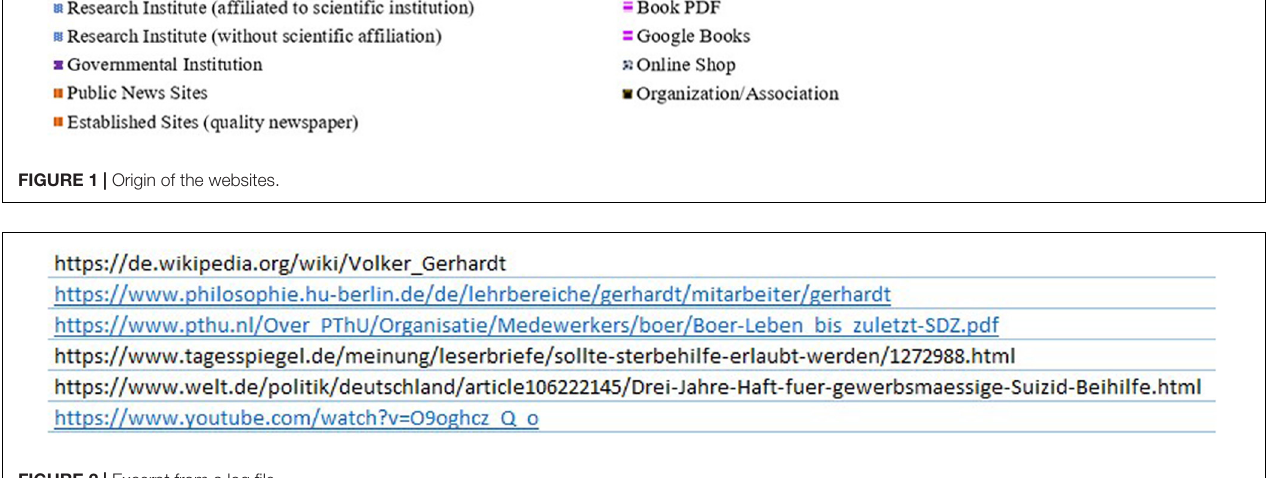
FIGURE 2 | Excerpt from a log